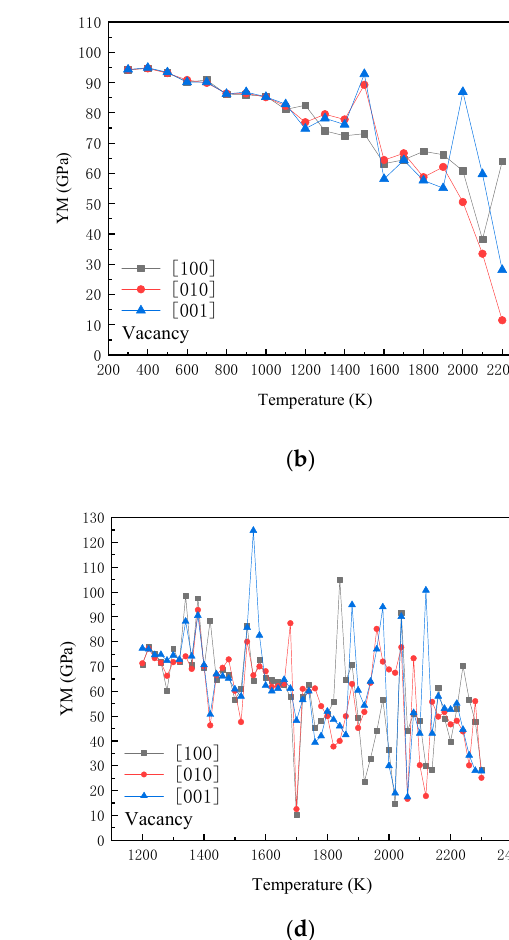
Figure 3. Variation of Young’s modulus with the temperature: ( a ) perfect lattice with a temperature increase of 100 K; ( b ) lattice with one vacancy with a temperature increase of 100 K; ( c ) perfect lattice with a temperature increase of 20 K; ( d ) lattice with one vacancy with a temperature increase of 20 K.